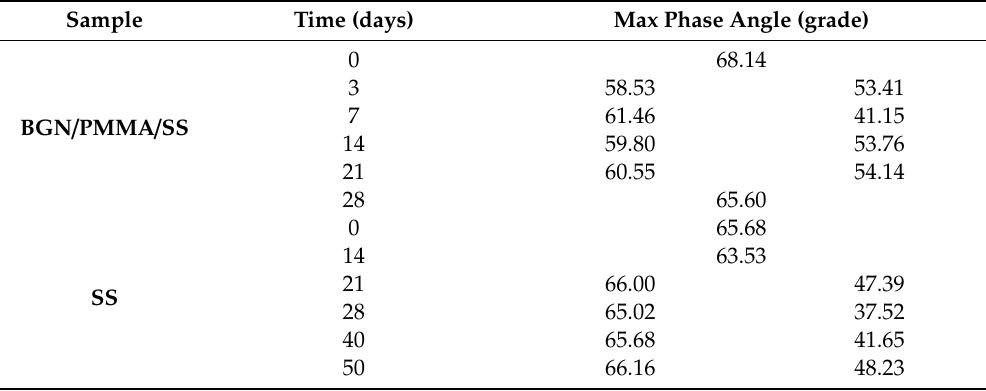
Table 4. Max phase angle for BGN / PMMA / SS and SS samples after di ff erent immersion time.